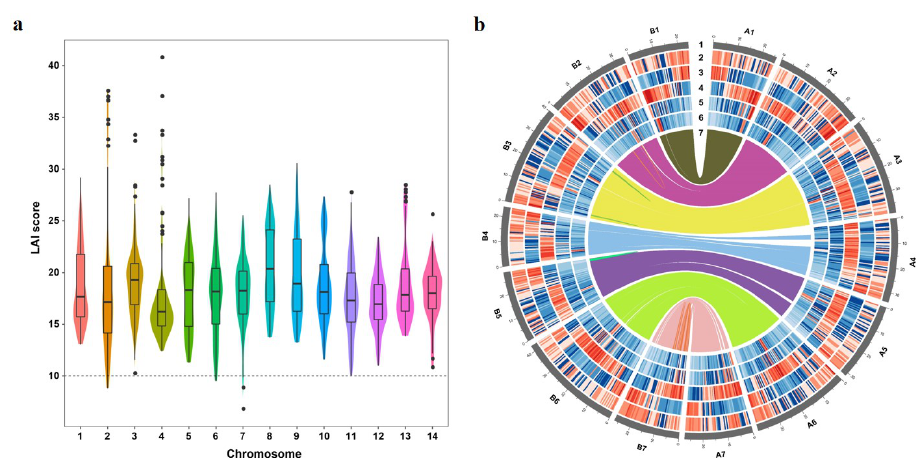
Figure 2. LAI scores and genome landscape of 14 chromosomes. ( a ) LAI scores distribution of Poan 14 chromosomes. The LAI score between 10 and 20 means the assembly reached the reference genome level. ( b ) Circos plot of genomic features. The tracks from the outermost to innermost are: 1 chromosome, 2 GC content, 3 gene density, 4 repeat density, 5 LTR-Gypsy density, 6 LTR-Copia density, and 7 collinear genes of Poan genome. The data are shown with a 500 Kb